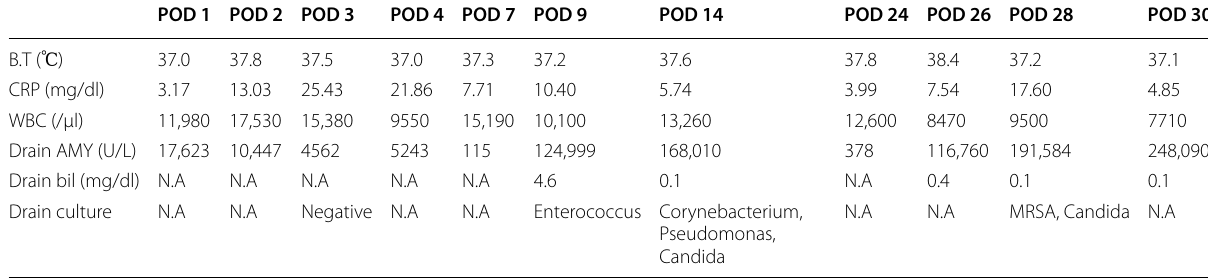
N.A. not assessed